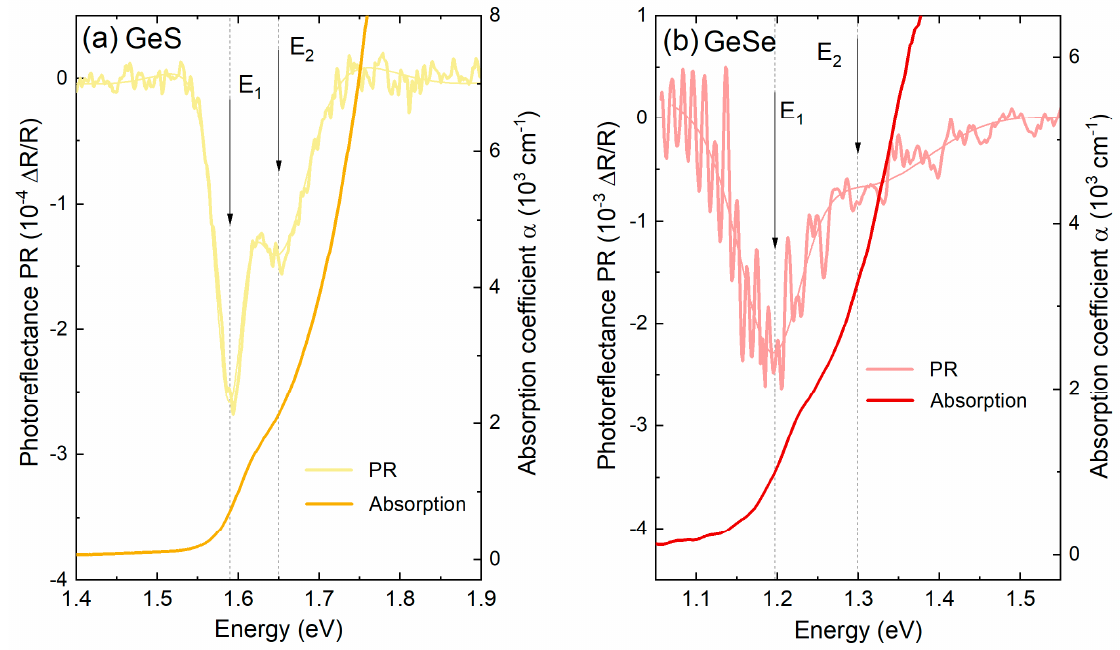
Figure 5. Photoreflectance and optical absorption spectra of ( a ) GeS and ( b ) GeSe. Thin solid lines over the PR plots are the curves resulting from fitting with Aspnes formula (Equation (3)). Vertical arrows mark the energies of the optical transitions E 1 and E 2 , determined from PR spectra.